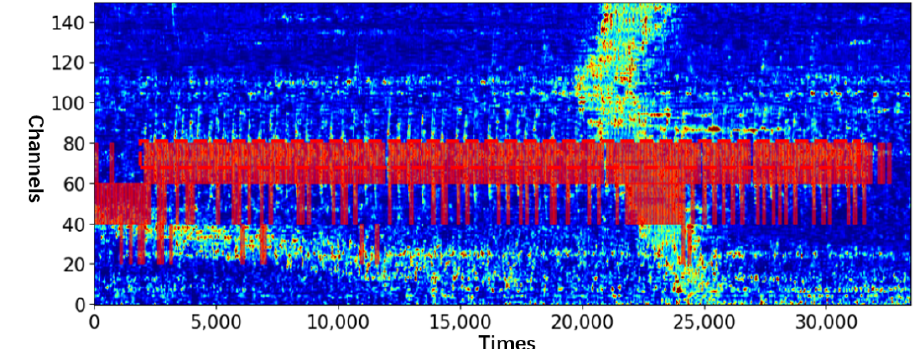
Figure 8. Before the accumulation of the model test result window, the red boxes are the detected intrusion windows (scanning period = 128 and channel width = 20).